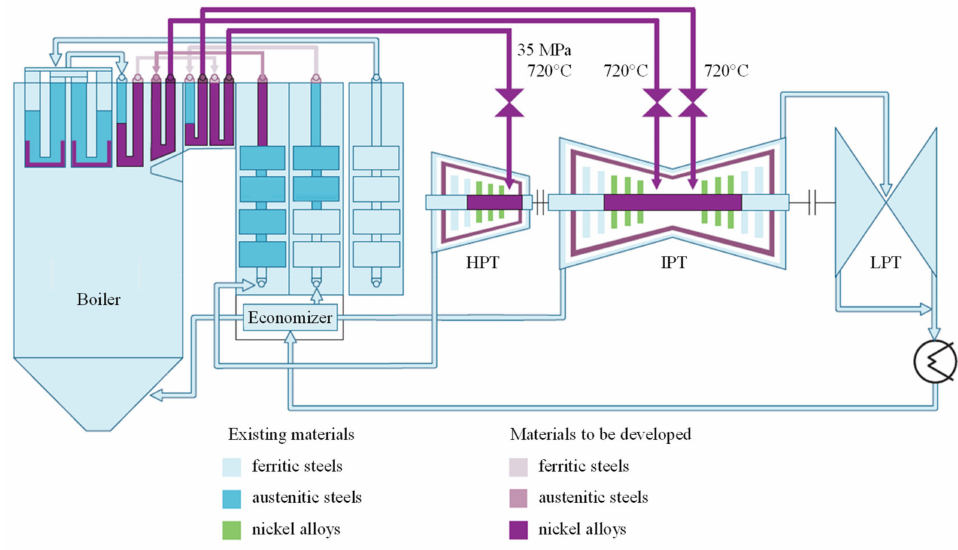
Figure 4. Heat-resistant materials in the USC power facility